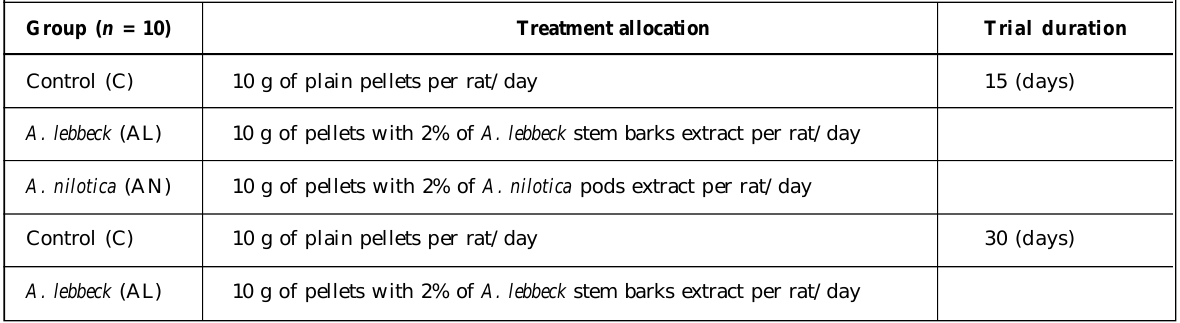
Table 1: Experimental design. To evaluate the contraceptive potential of A. nilotica pods and A. lebbeck stem bark methanolic extracts in the male M.